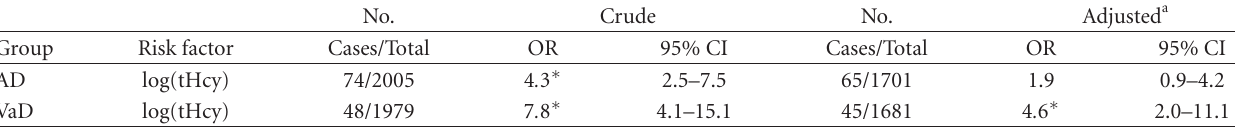
Table 3: Comparison of risk associated with total homocysteine (tHcy) for Alzheimer’s disease (AD) and vascular dementia (VaD). No. Crude